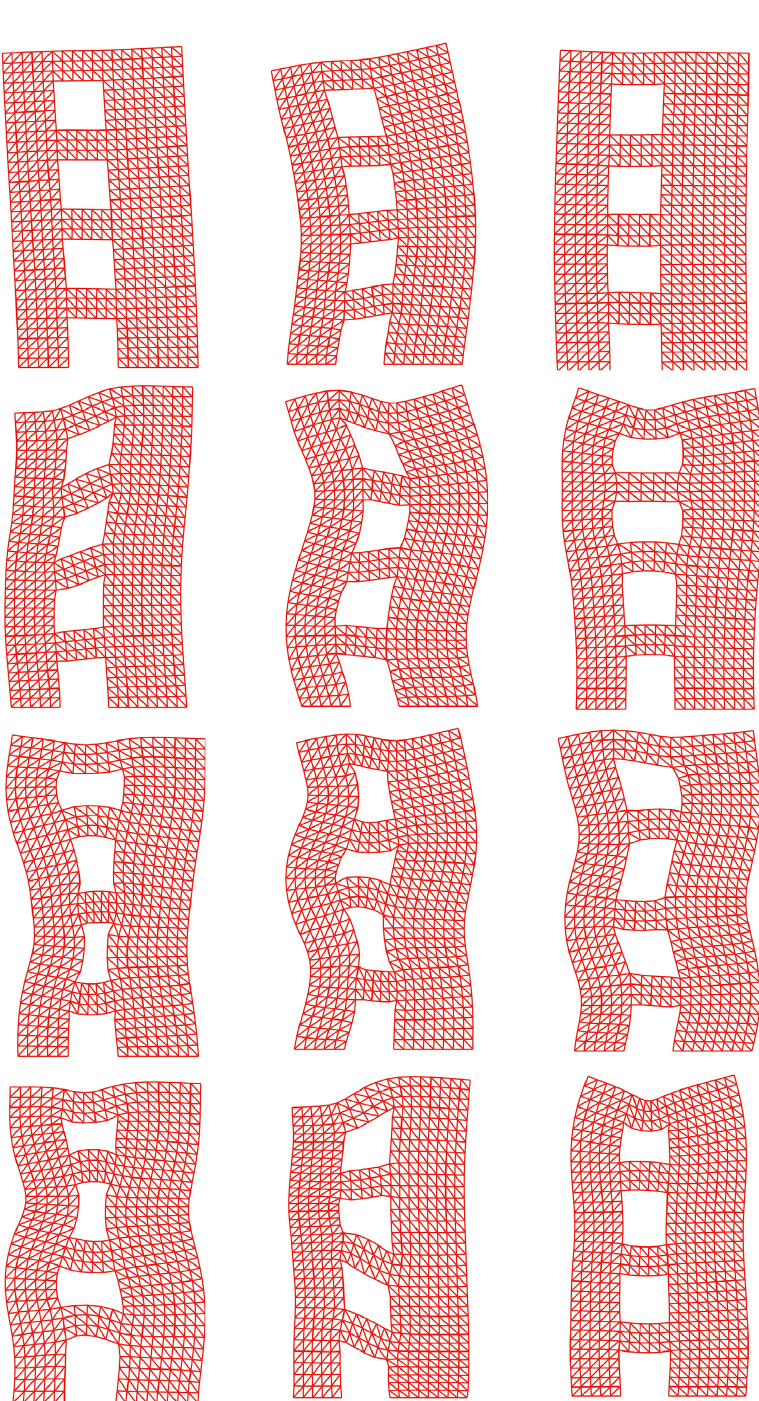
Figure 27: First 12 modes of shear wall by GS-FEM.